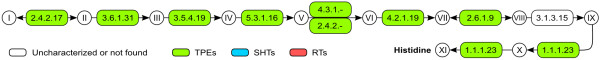
Histidine synthesis pathway. Enzymes surrounded by a thick gray box were shown to be horizontally transferred from Bacteria (see main text). Metabolites – I: 5-phosphoribosyl diphosphate (PRPP); II: phosphoribosyl-ATP; III: phosphoribosyl-AMP; IV: phosphoribosyl-formimino-AICAR phosphate; V: phosphoribulosyl-formimino-AICAR phosphate; VI: imidazole-glycerol 3-phosphate; VII: imidazole-acetol phosphate; VIII: histidinol phosphate; IX: histidinol; X: histidinal; XI: histidine. Enzymes – 2.4.2.17: ATP phosphoribosyltransferase; 3.6.1.31: phosphoribosyl-ATP pyrophosphohydrolase; 3.5.4.19: phosphoribosyl-AMP cyclohydrolase; 5.3.1.16: phosphoribosylformimino-5-aminoimidazole carboxamide ribotide isomerase; 4.1.3.-: cyclase HisF; 2.4.2.-: glutamine amidotransferase; 4.2.1.19: imidazole-glycerol phosphate dehydratase; 2.6.1.9: histidinol phosphate aminotransferase; 3.1.3.15: histidinol phosphatase; 1.1.1.23: histidinol dehydrogenase. Abbreviations as for Figure 1.